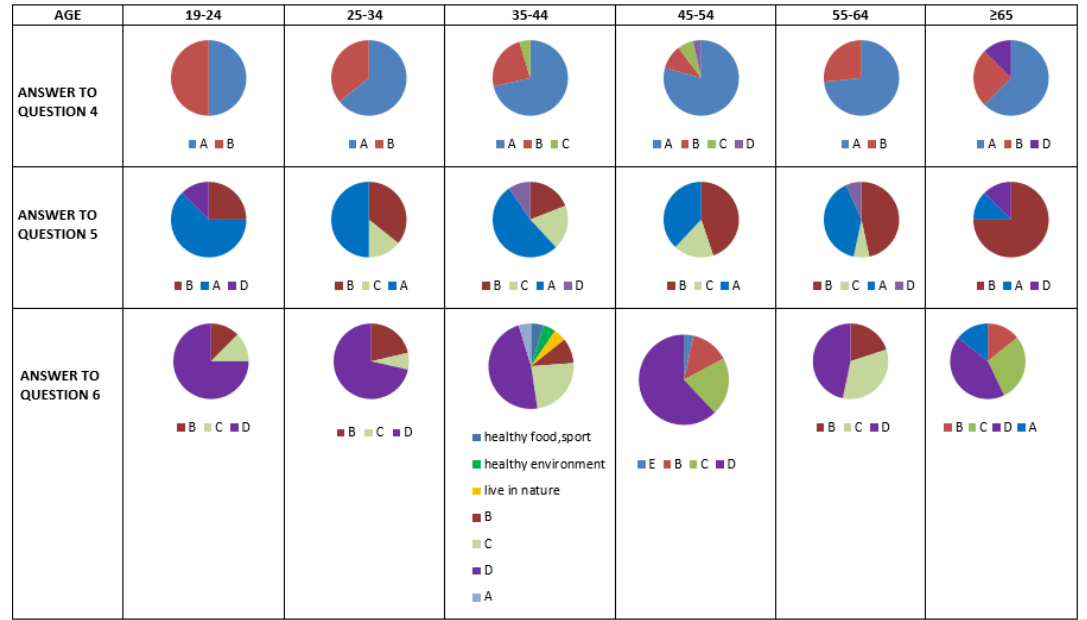
Figure 4. Distribution of responses to the SANI survey questionnaire by age group. Question 4: What